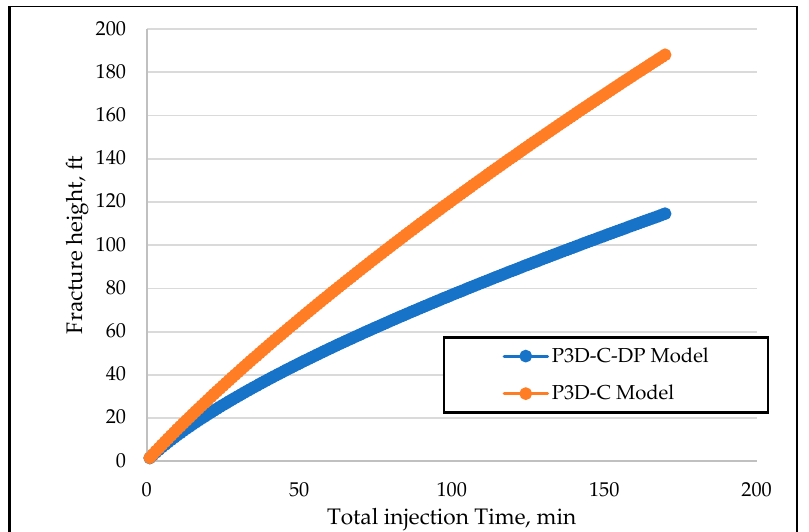
Figure 7. Fracture height growth versus total injection time for P3D-C and P3D-C-DP models.